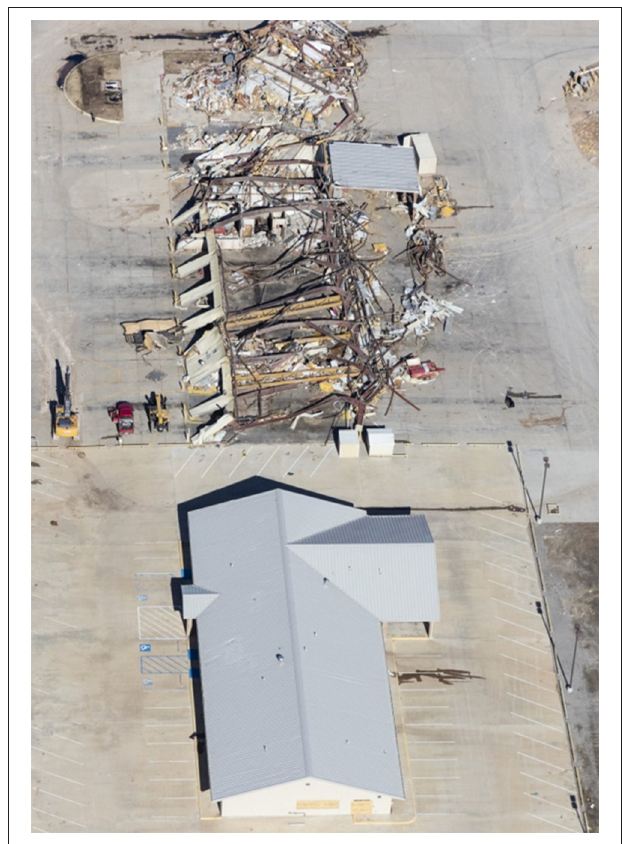
FIGURE 10 | Low-level (5-cm) aerial imagery of metal building structures damaged by the EF-3 tornado at the Halliburton Oilfield Services facility outside Pampa, TX, in November 2015. (Image Credit: Authors/Aerial Oklahoma